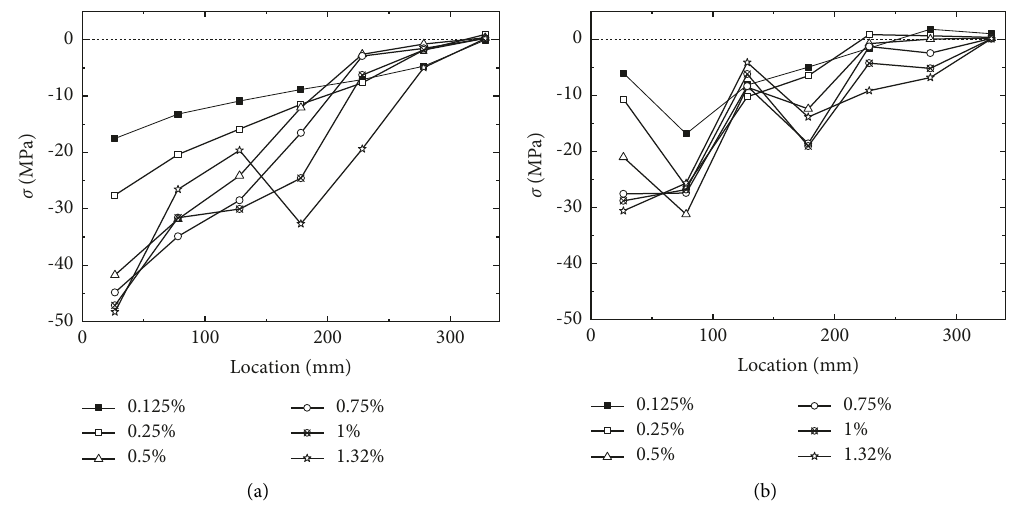
Figure 19: Concrete stress distributions of core walls with varied coupling beam span-depth ratios: (a) l / h � 1.25, n � 0.1. (b) l / h � 2.5, n �